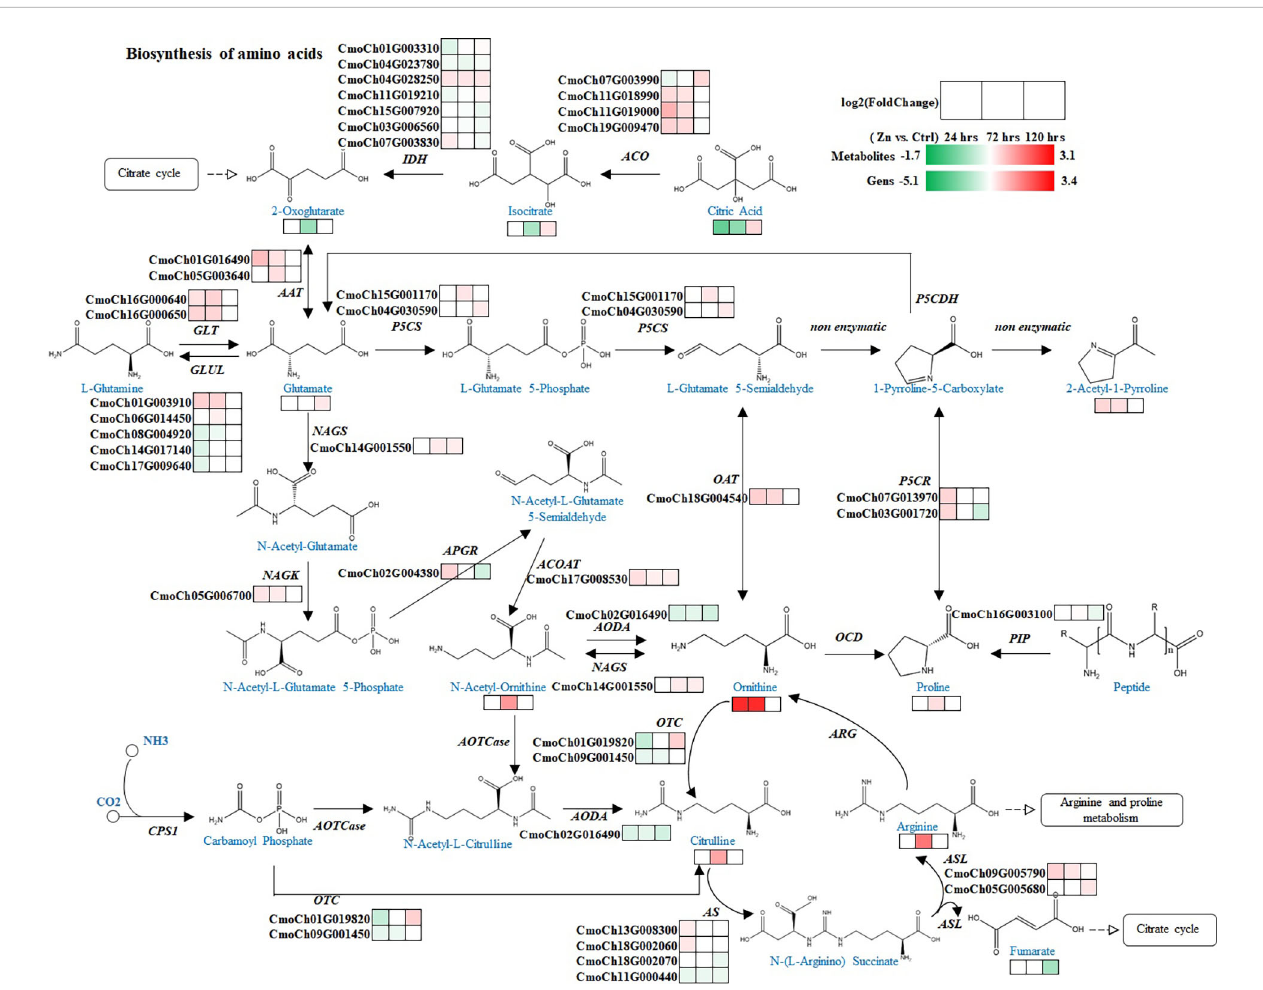
FIGURE 4 Regulation of pathways related to 2-AP biosynthesis. Blue and black colors are metabolites and genes involved in the pathway, respectively. Heatmaps illustrate the regulations of metabolites and genes at different time-points after Zn treatment. Red and green colors represent increase and decrease in abundance of metabolites or genes. Abbreviations, full names and EC numbers of enzymes: ACO aconitate hydratase [EC:4.2.1.3]; IDH isocitrate dehydrogenase [EC:1.1.1.42]; AAT aspartate aminotransferase [EC:2.6.1.1]; GLT glutamate synthase [EC:1.4.1.14]; GLUL glutamine synthetase